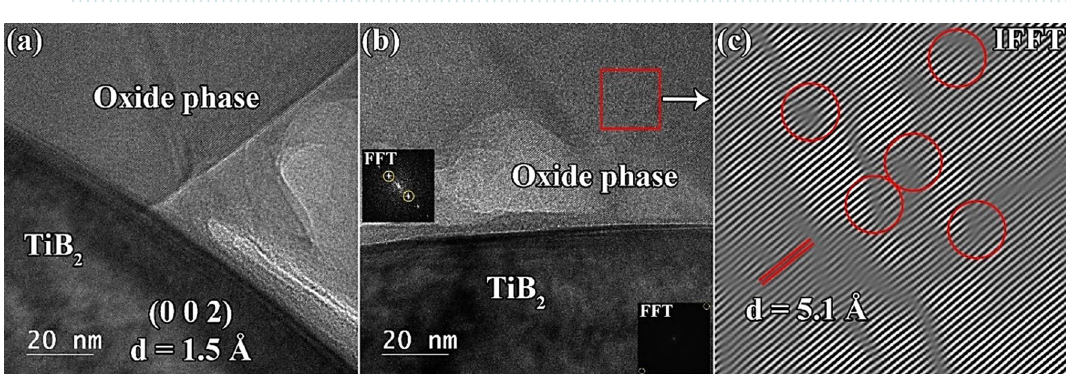
Figure 9. ( a and b ) HRTEM images of C f -incorporated TiB 2 –SiC composite showing a TiB 2 /residual oxide interface, and ( c ) the corresponding IFFT